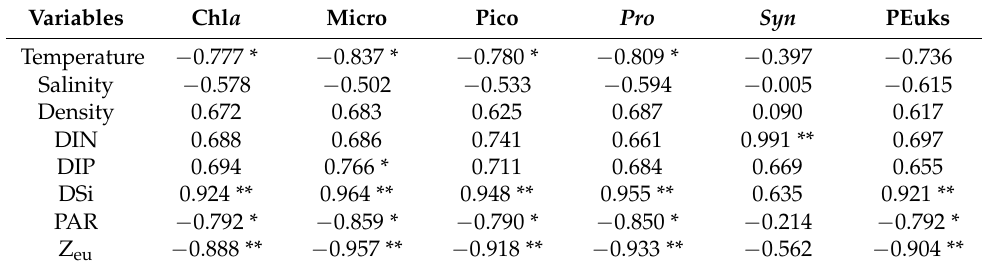
Table 2. Pearson’s correlation coefficients between environmental factors and abundance of phyto- plankton ( n =